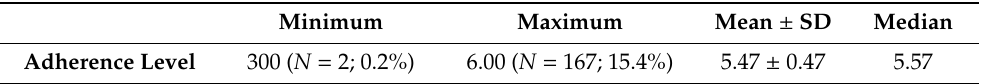
Table 3. Minimum, maximum, mean and median of the adherence